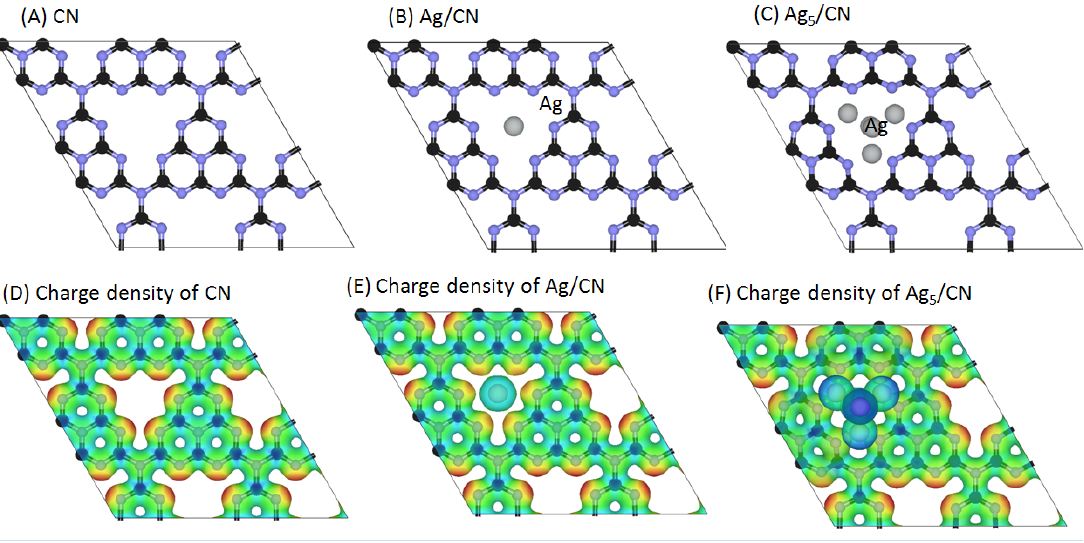
Figure 4. The adsorption configurations of ( A ) CN; ( B ) Ag/CN; ( C ) Ag 5 /CN and the simulation of charge density of ( D ) CN; ( E ) Ag/CN and ( F ) Ag 5 /CN.